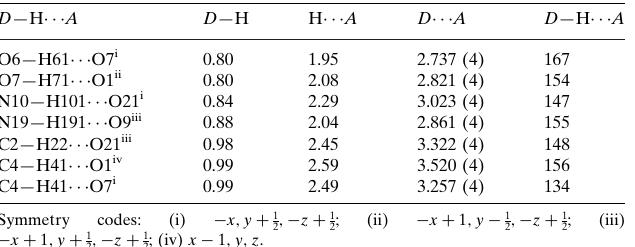
Hydrogen-bond geometry (A ˚ , (cid:5)